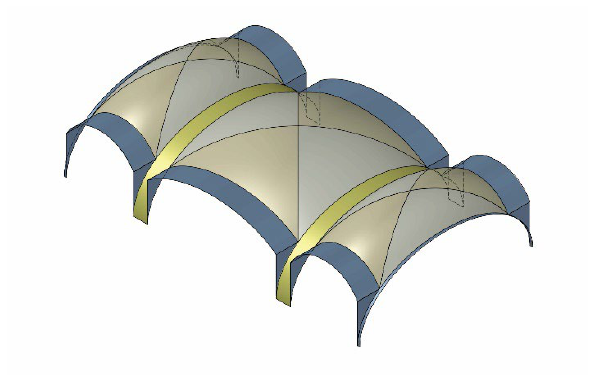
Figure 15. 3D interpretative model of the vault of room 1 (Modelling: F. Natta)